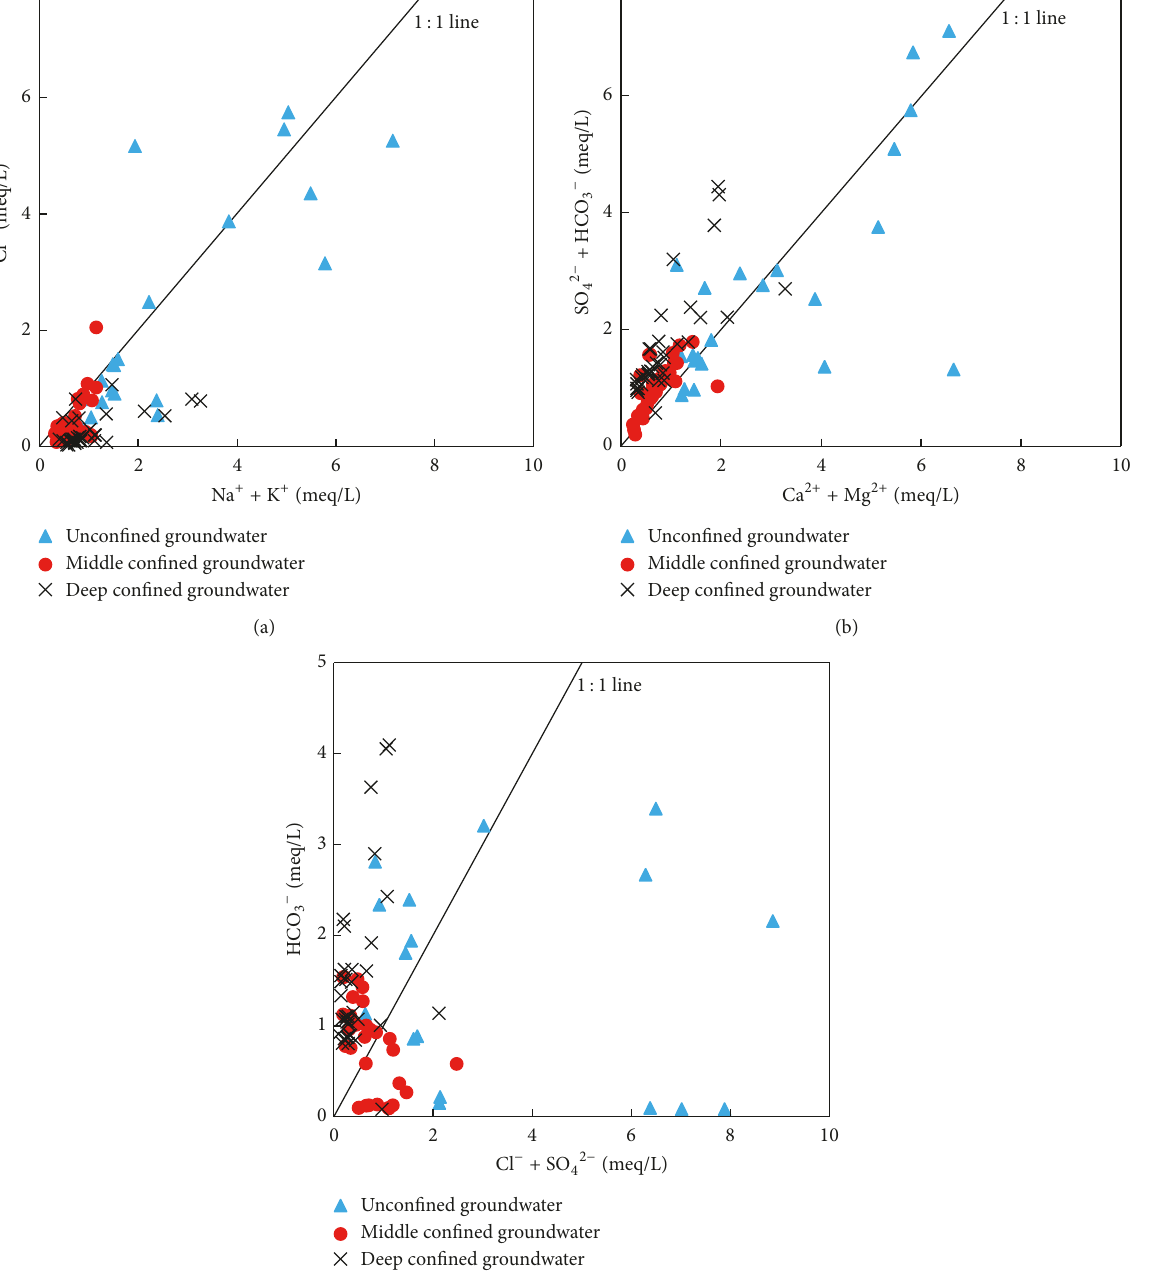
fall below the 1 : 1 line, which indicates that the combined dissolutions of carbonate and silicate are the main sources of Ca 2+ and Mg 2+ in the unconfined groundwater